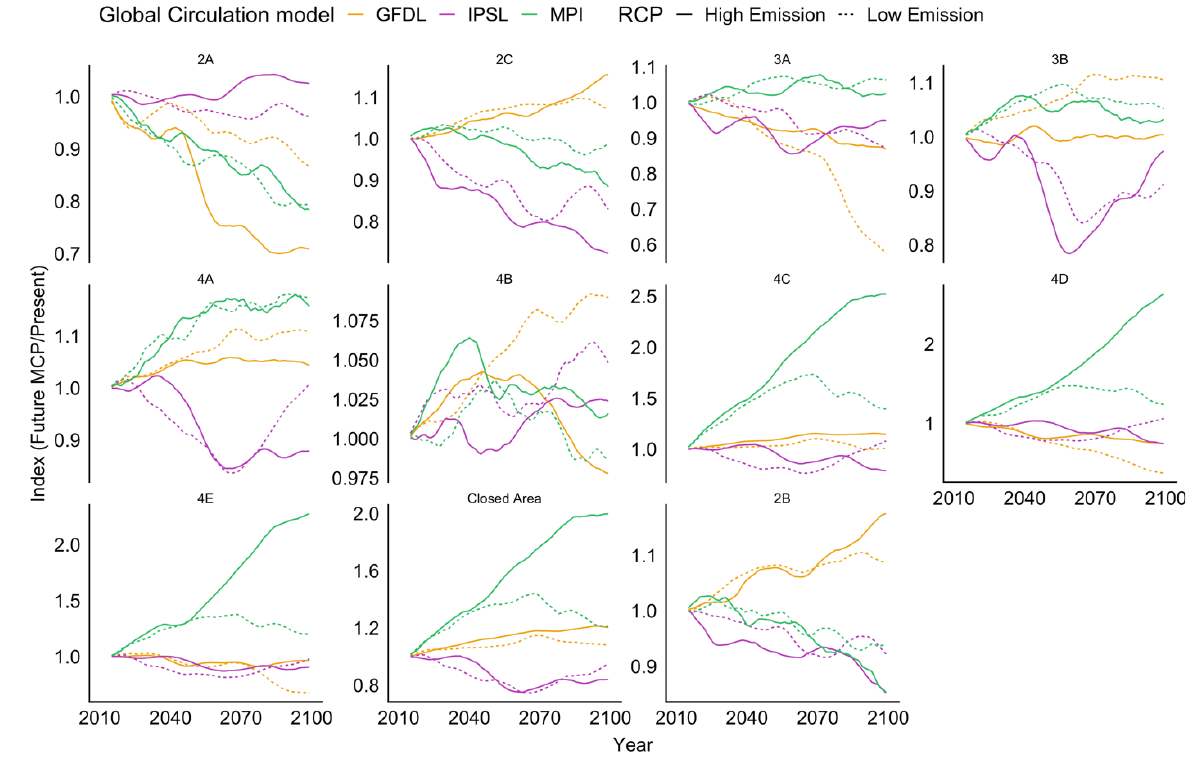
Fig A2.4. Projected max catch potential change relative to present (2005-2014) for each IPHC regulatory area. Colors represents the different ESM used in the study. Solid line represents a high emission scenario (RCP 8.5) and dashed line represents a low emission scenario (RCP